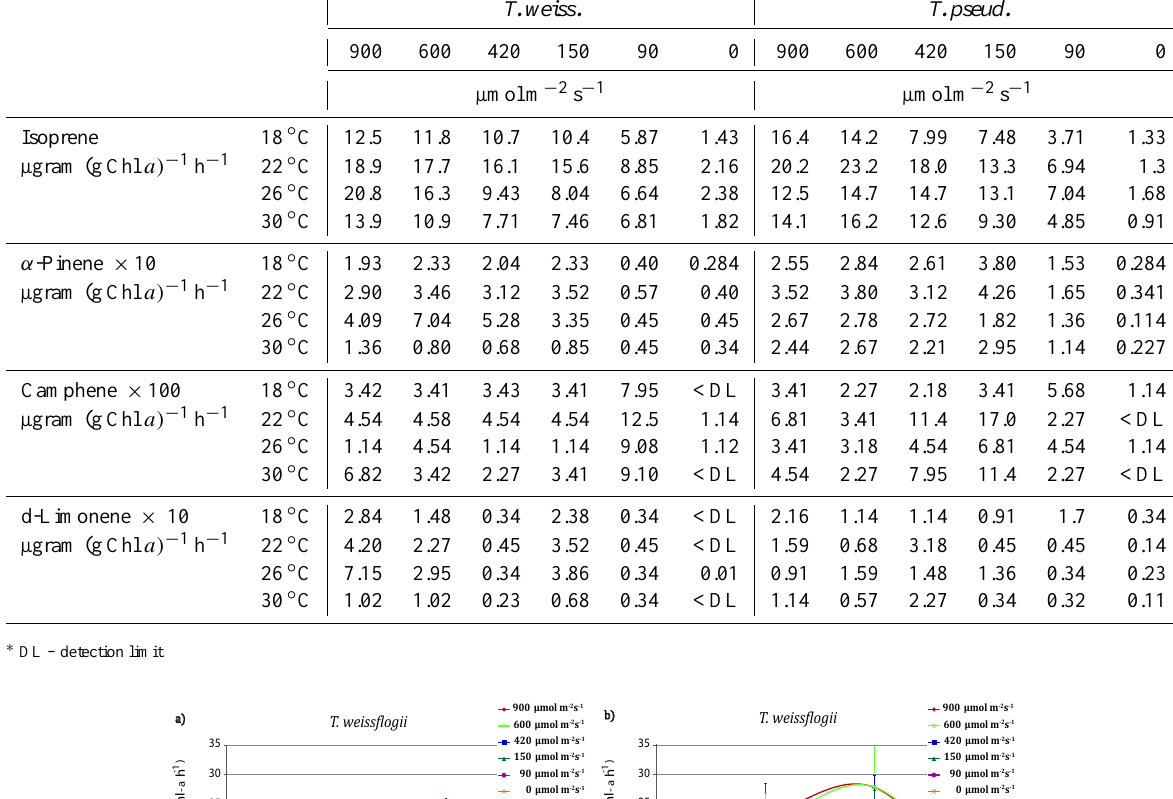
Table 3. Isoprene and monoterpene production rates from phytoplankton monocultures averaged over a 12h period on the first day ∗ . T. weiss. T. pseud.